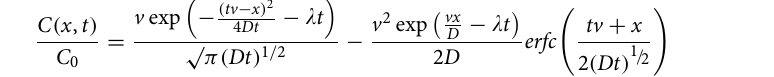
where C( x ,t) is the concentration of tracer (D 2 O or 137 Cs), to be solved under the following initial and two boundary conditions: initial condition : C(x,0) = 0, two boundary conditions: inlet boundary condition